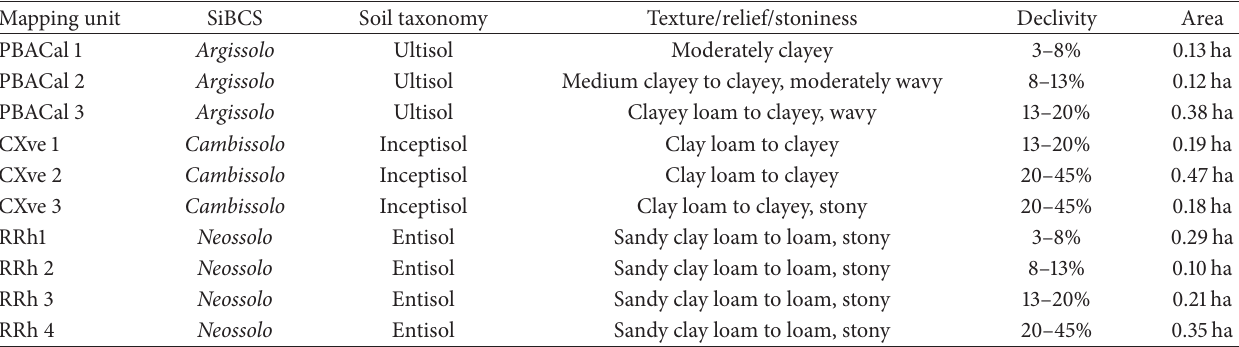
Table 1: Properties of the units of soil [8]. Symbols based on Brazilian System of Soil Science (SiBCS) and correspondence SiBCS and soil